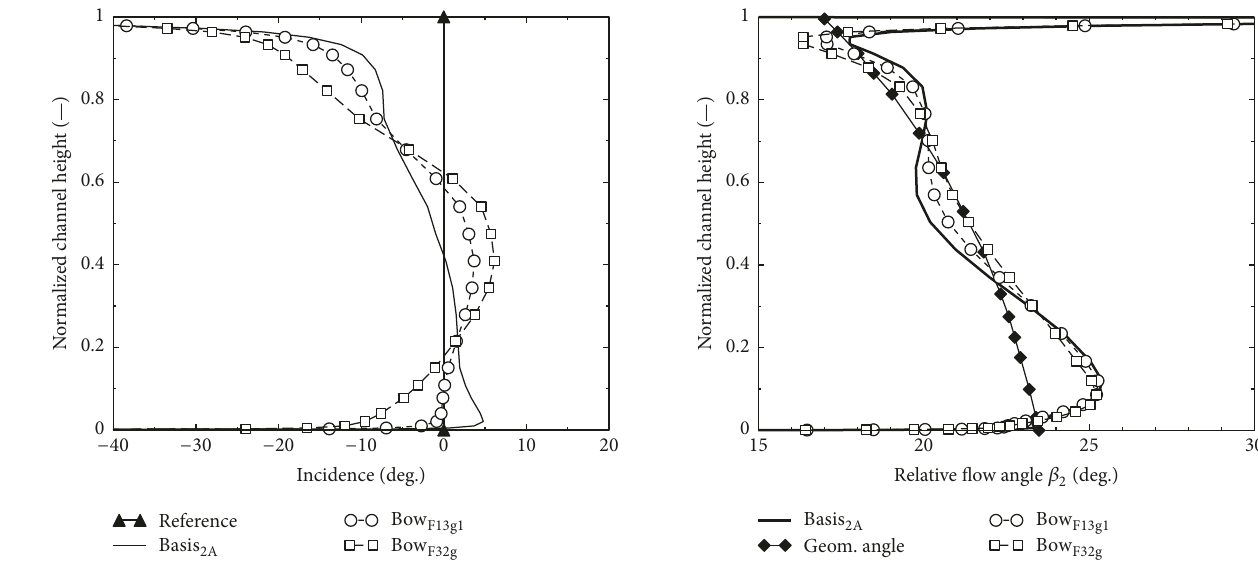
Figure 13: Circumference averaged incidence of the rotor over the channel height.